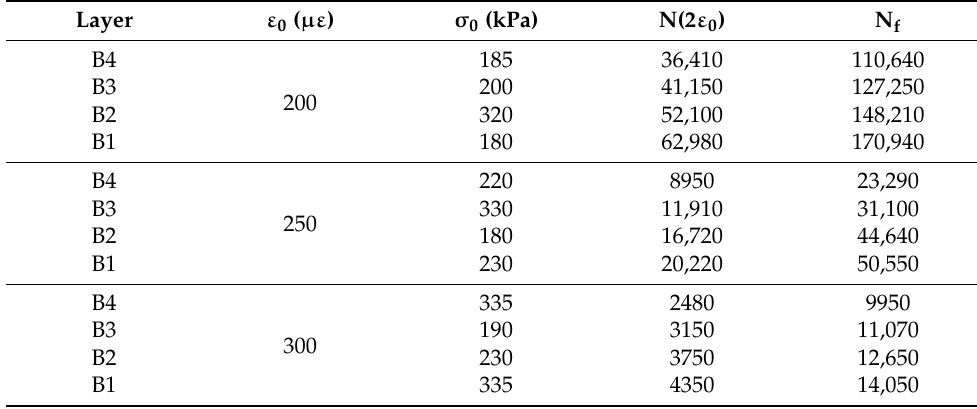
Table 8. Results of fatigue tests—binder